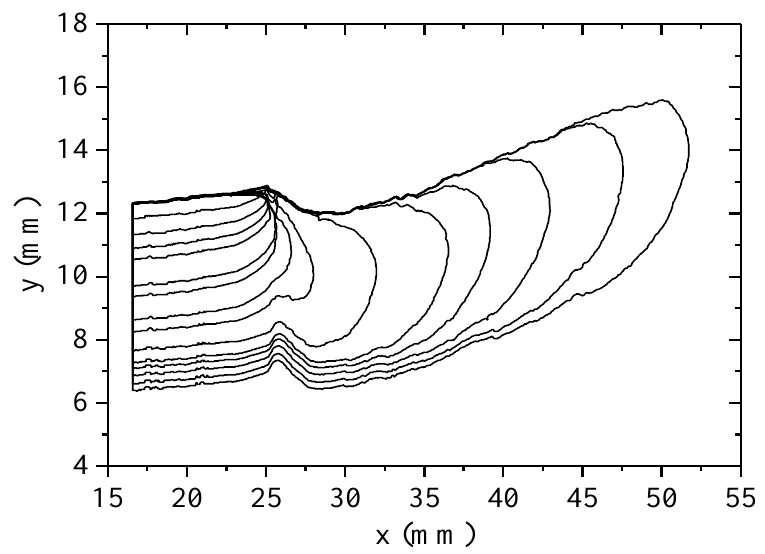
Figure 10. Crack front profiles for different load stages. x and y represent the coordinate positions of the points forming the crack contour, and its coordinate axis direction is shown in Figure 1.